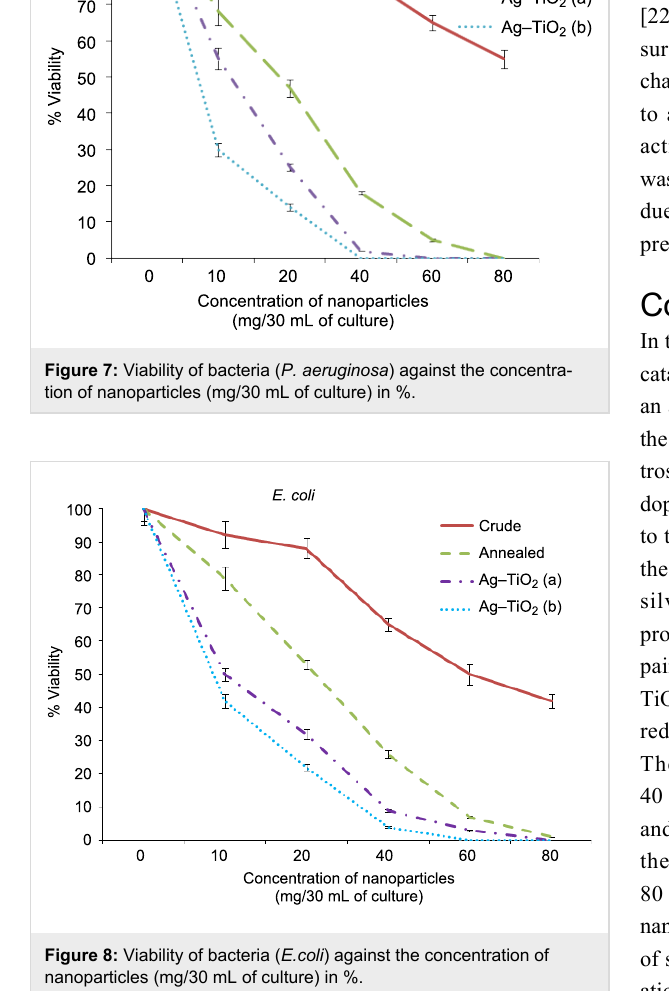
rutile phases, and shows an indirect band gap of 3.2 eV,